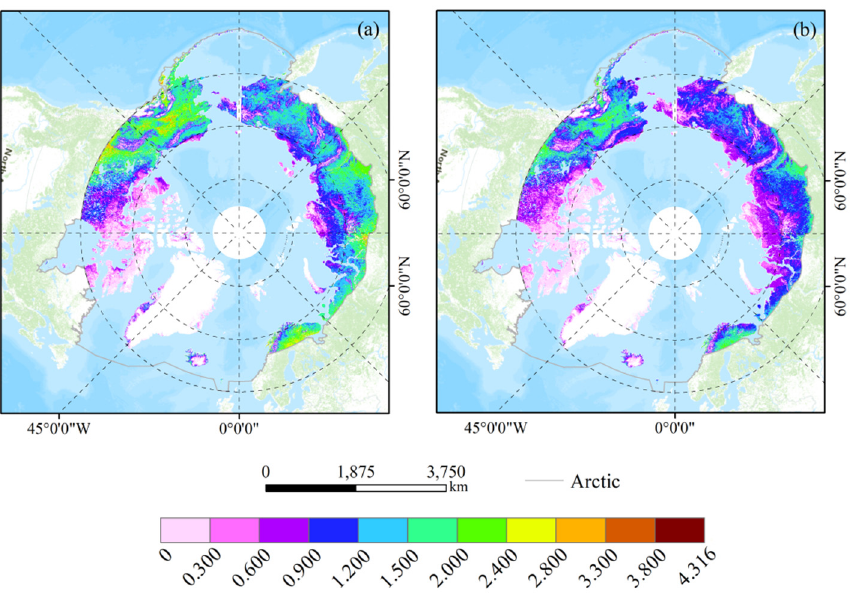
Figure 10. The spatial distribution characteristics of annual-maximum ( a ) and annual-averaged GPP ( b ) over the Arctic. Units of GPP are g C m − 2 d − 1 . ( b ) over the Arctic. Units of GPP are g C m − 2 d − 1 .